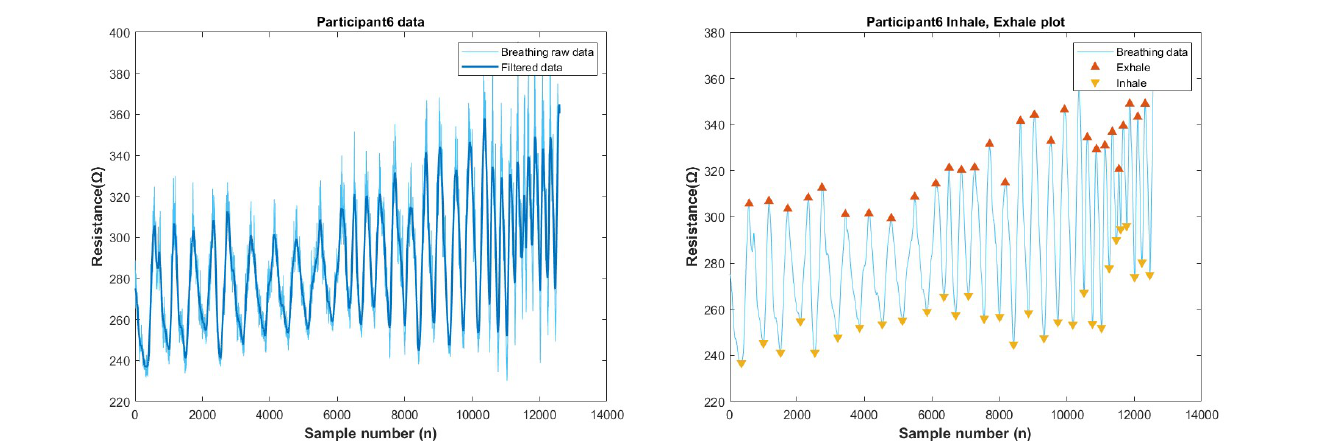
Figure A20. Breathing Test data of Participant number-5.